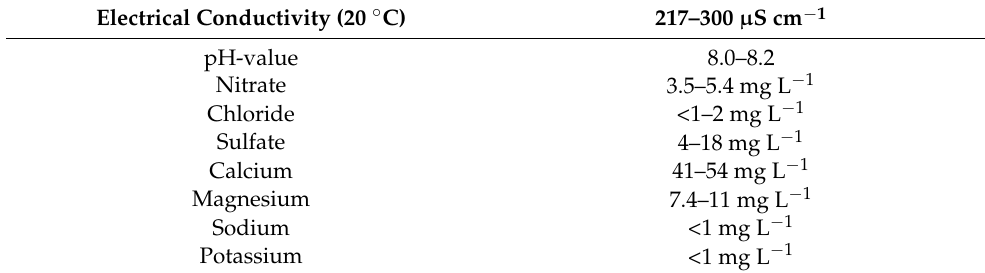
Table 2. Analysis of the tap water in Vienna from the water supply company, Vienna, 8 February 2021 (https://www.wien.gv.at/wienwasser/qualitaet/ergebnis.html (accessed on 5 April